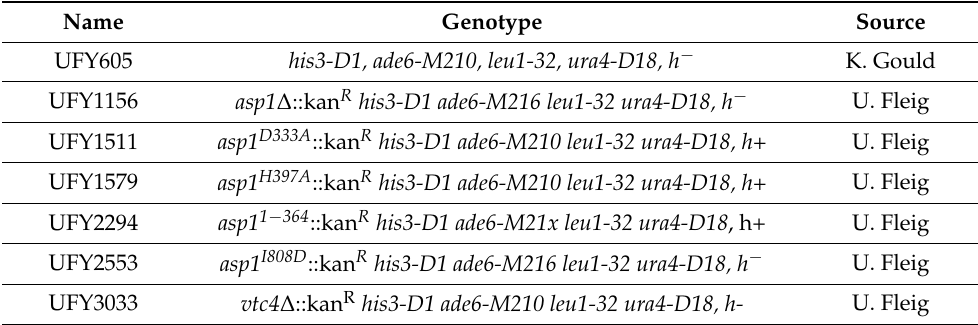
Table 1. Yeast cultures were grown in rich medium (YE5S) or as indicated in the text. Table 1. S. pombe strains used in this